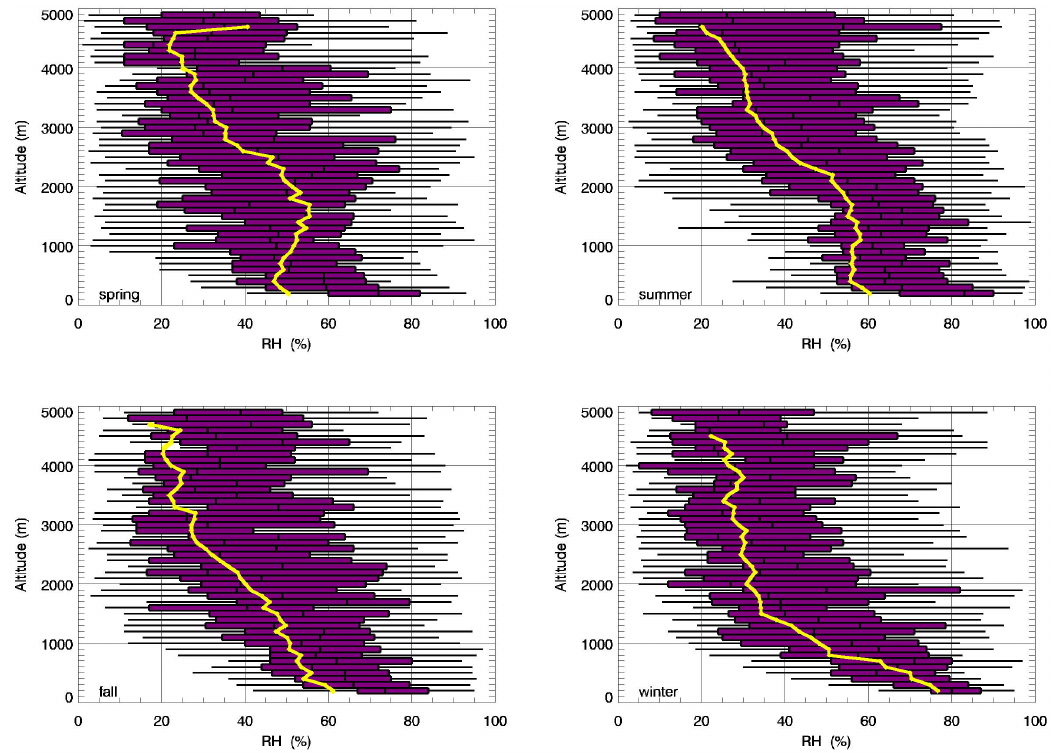
Fig. 7. Seasonal vertical profiles of the RH from the atmospheric soundings at Lincoln, Illinois, corresponding to AAO flights (box-whisker plots) and the median RH from the AAO flights (yellow